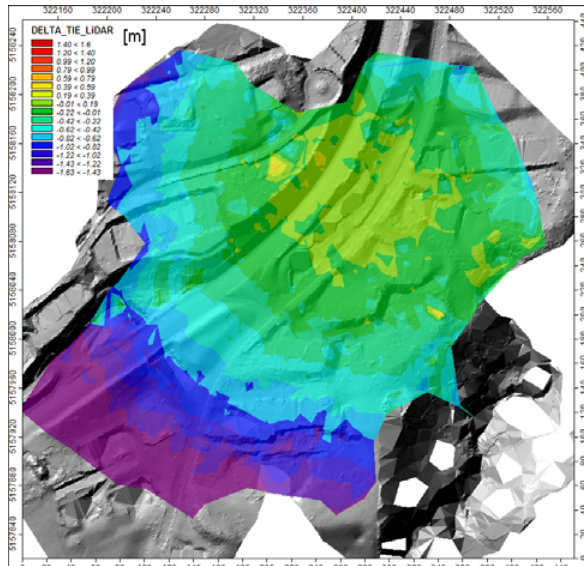
Figure 8: Height differences between SocetSet tie points (on ground) and LiDAR DTM.